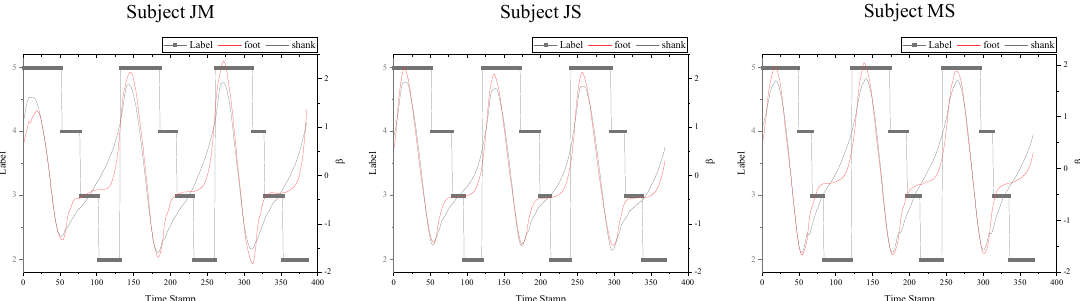
Figure 13. Pitch angles of foot and shank of three subjects.